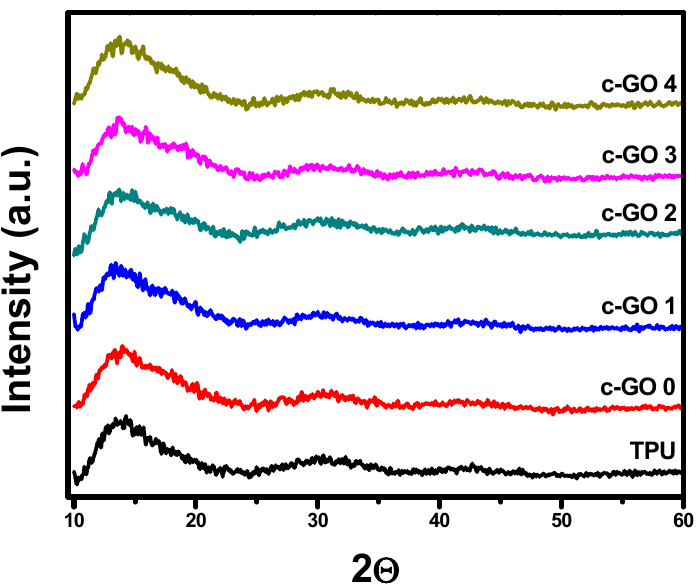
Figure 4. XRD pattern of TPU, and c-GO based TPU membranes.